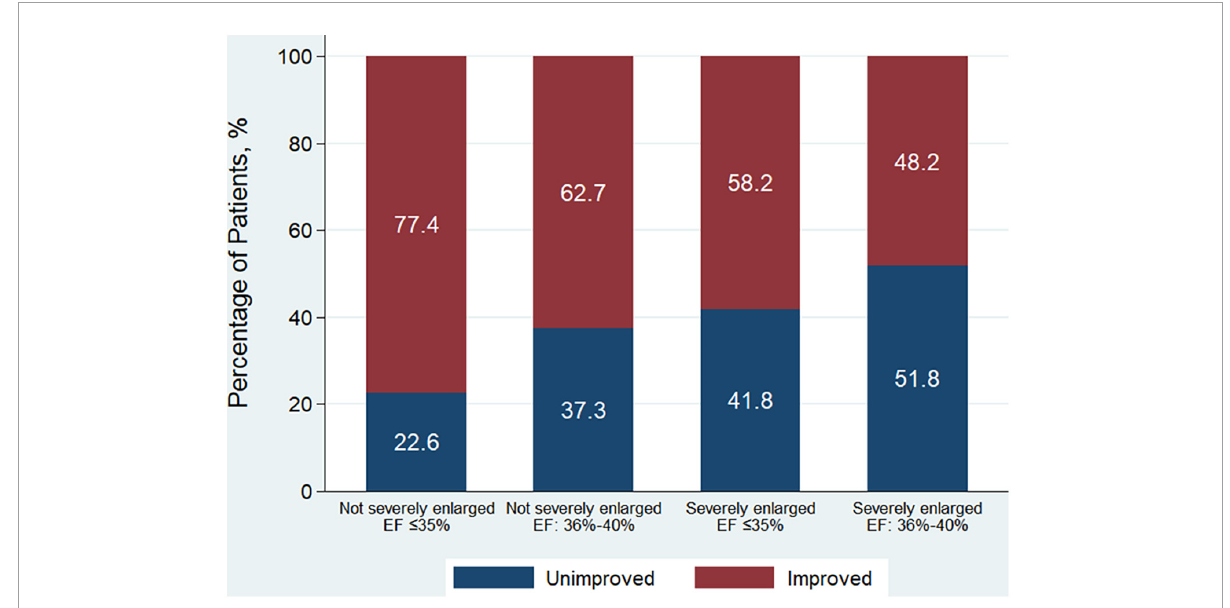
FIGURE2 Patient distribution according to the improvement of EF among 4 patient groups according to whether LVESD was severely enlarged or not, and EF ≤ 35% or of 36–40% at baseline. EF improvement was defined as absolute increase in EF > 5% following revascularization. Men with LVESD ≥ 46 mm and women with LVESD ≥ 42 mm were defined as severely enlarged LVESD. LVESD, left ventricular end-systolic diameter; EF, ejection